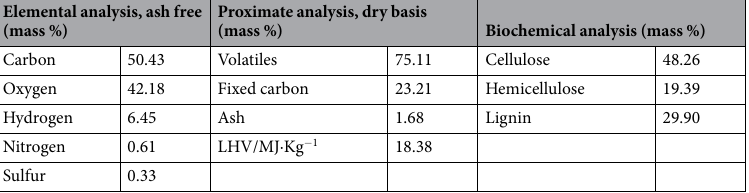
Table 2. Elemental, proximate and biochemical analysis of the